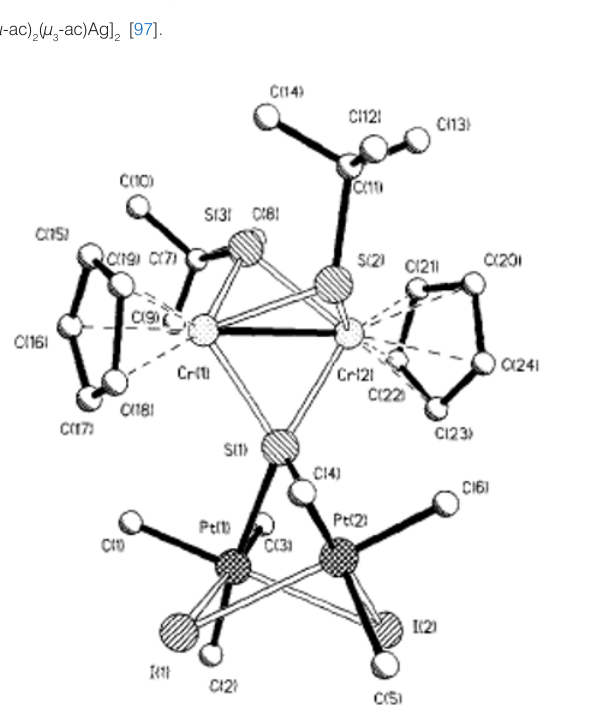
Figure 7. Structure of [{Me